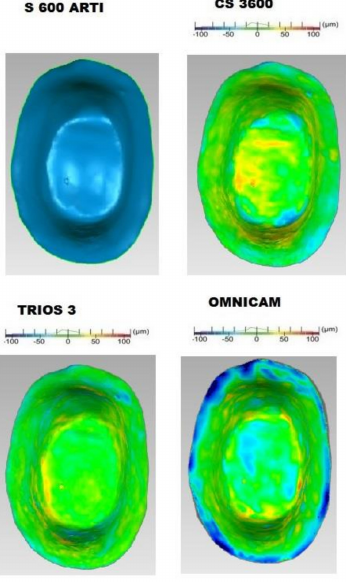
Figure 7. Comparison of complete preparation in OVA rendering S600ARTI and 3D comparison analysis for IOS without saliva in relation to the sample 3. Nominal histogram settings ± 25 microns and critical ± 100 microns.